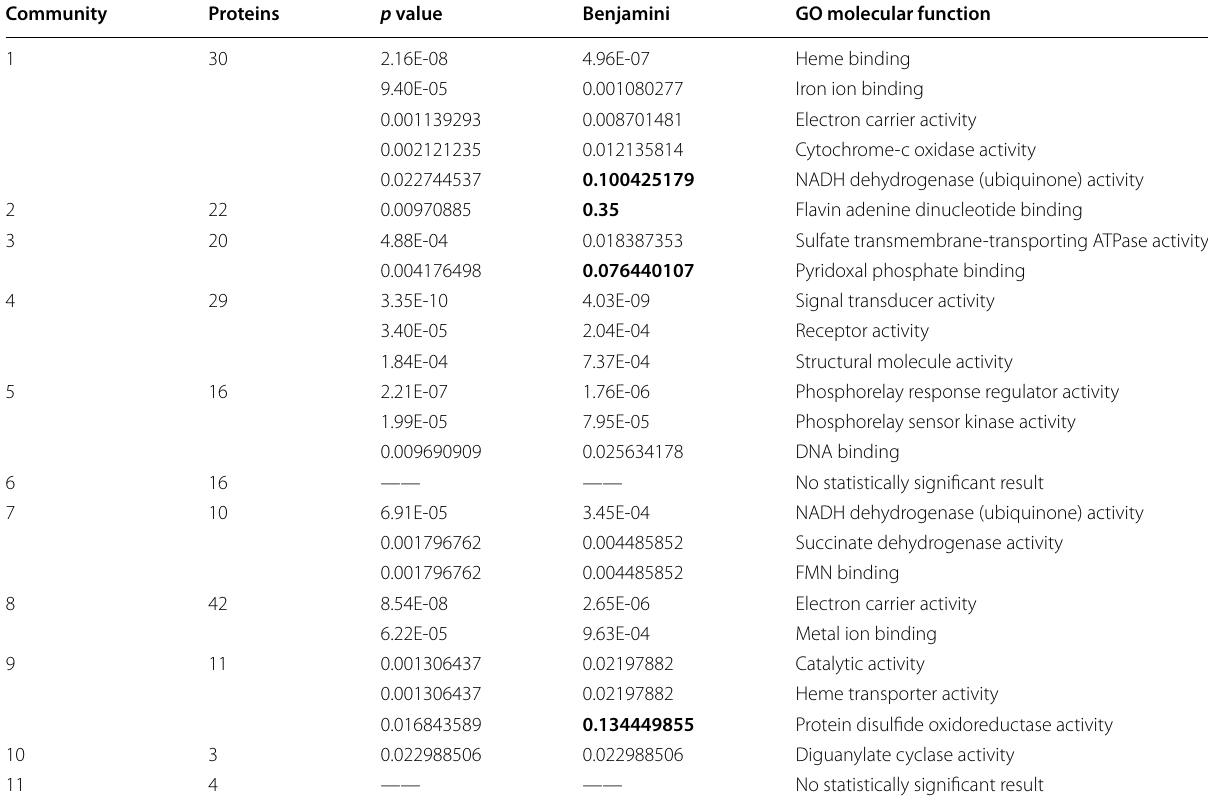
Table 2 The communities identified from the co‑fitness protein network in this study and the corresponding GO molecular functions